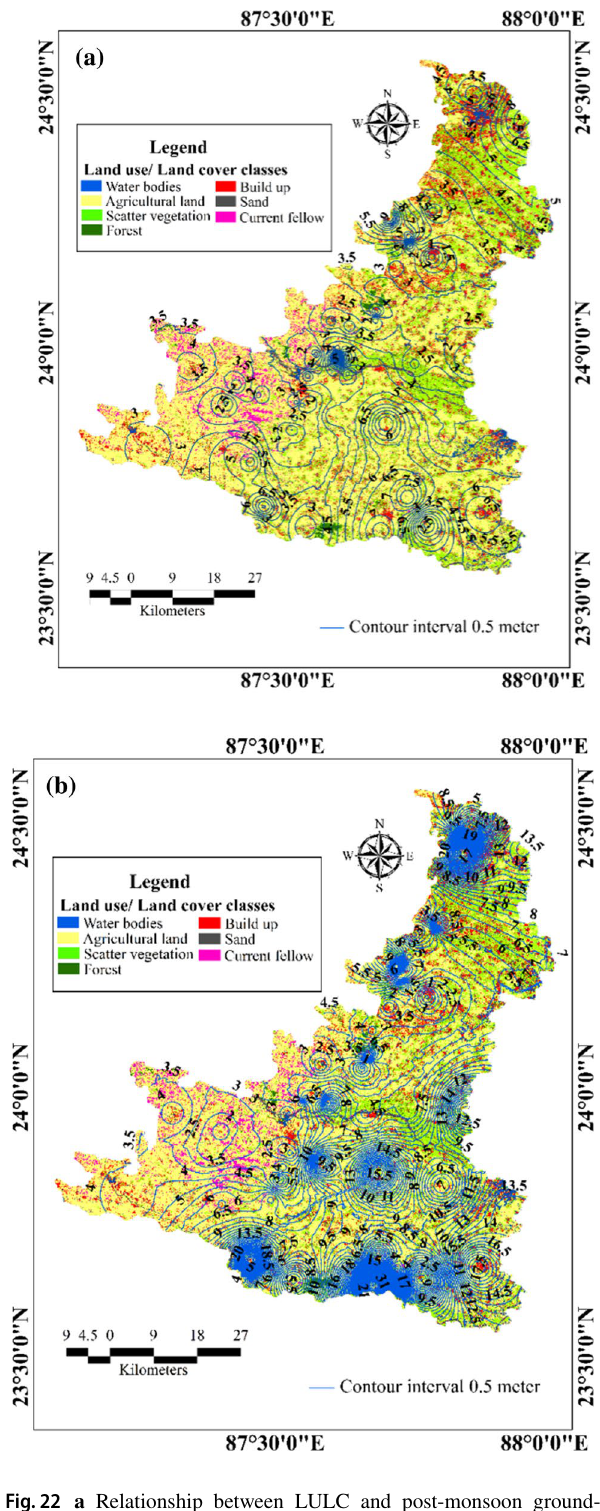
Fig. 22 a Relationship between LULC and post-monsoon ground- water level, 1996. b Relationship between LULC and post-monsoon groundwater level,